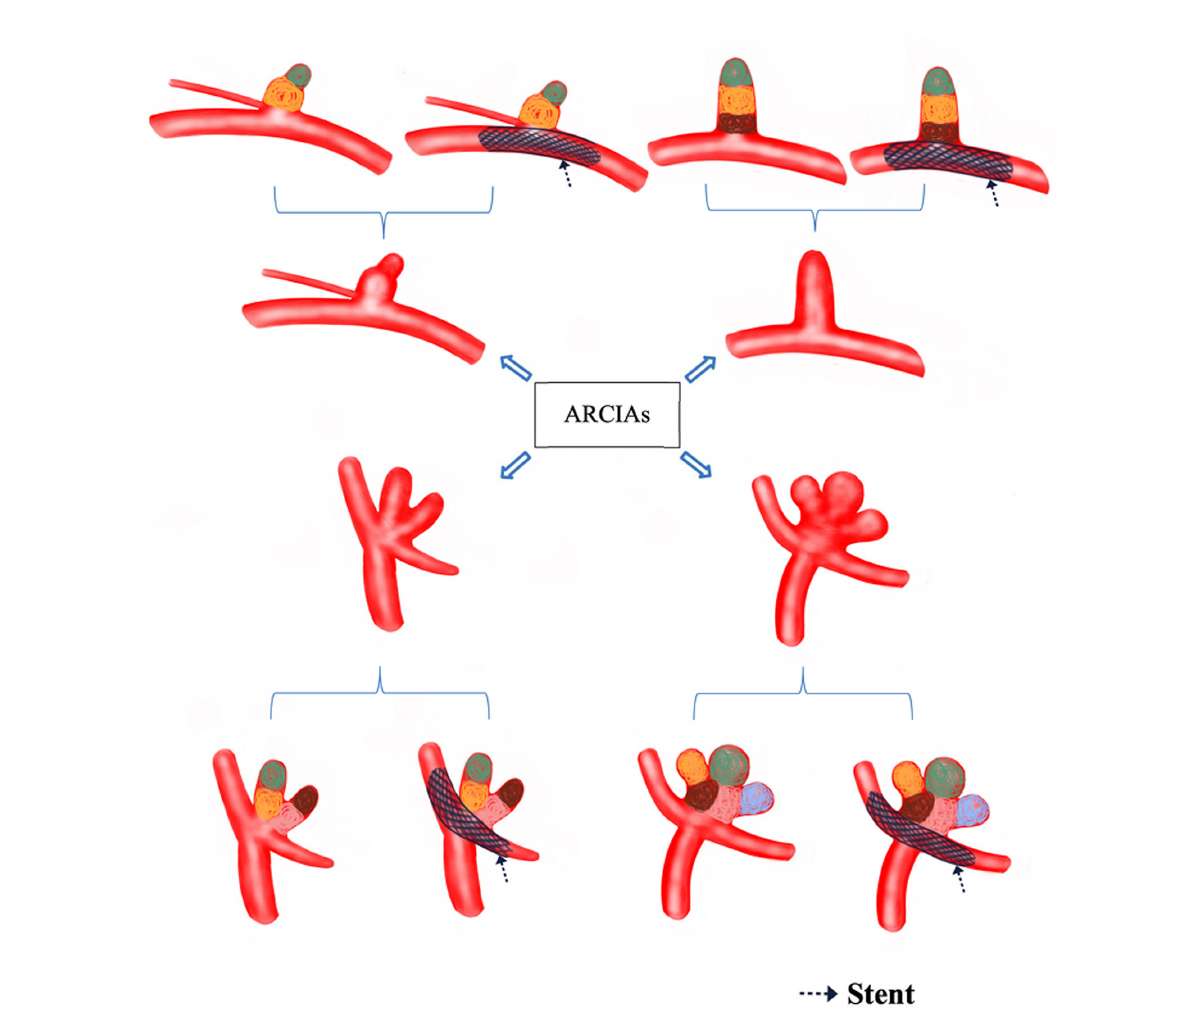
FIGURE1 Decision flow chart for treating ARCIAs. Black arrows indicate the stents (which can also be balloons) that assist in compartment packing. The different colored circles represent compartment packing in different compartments. ARCIAs, acutely ruptured complex intracranial